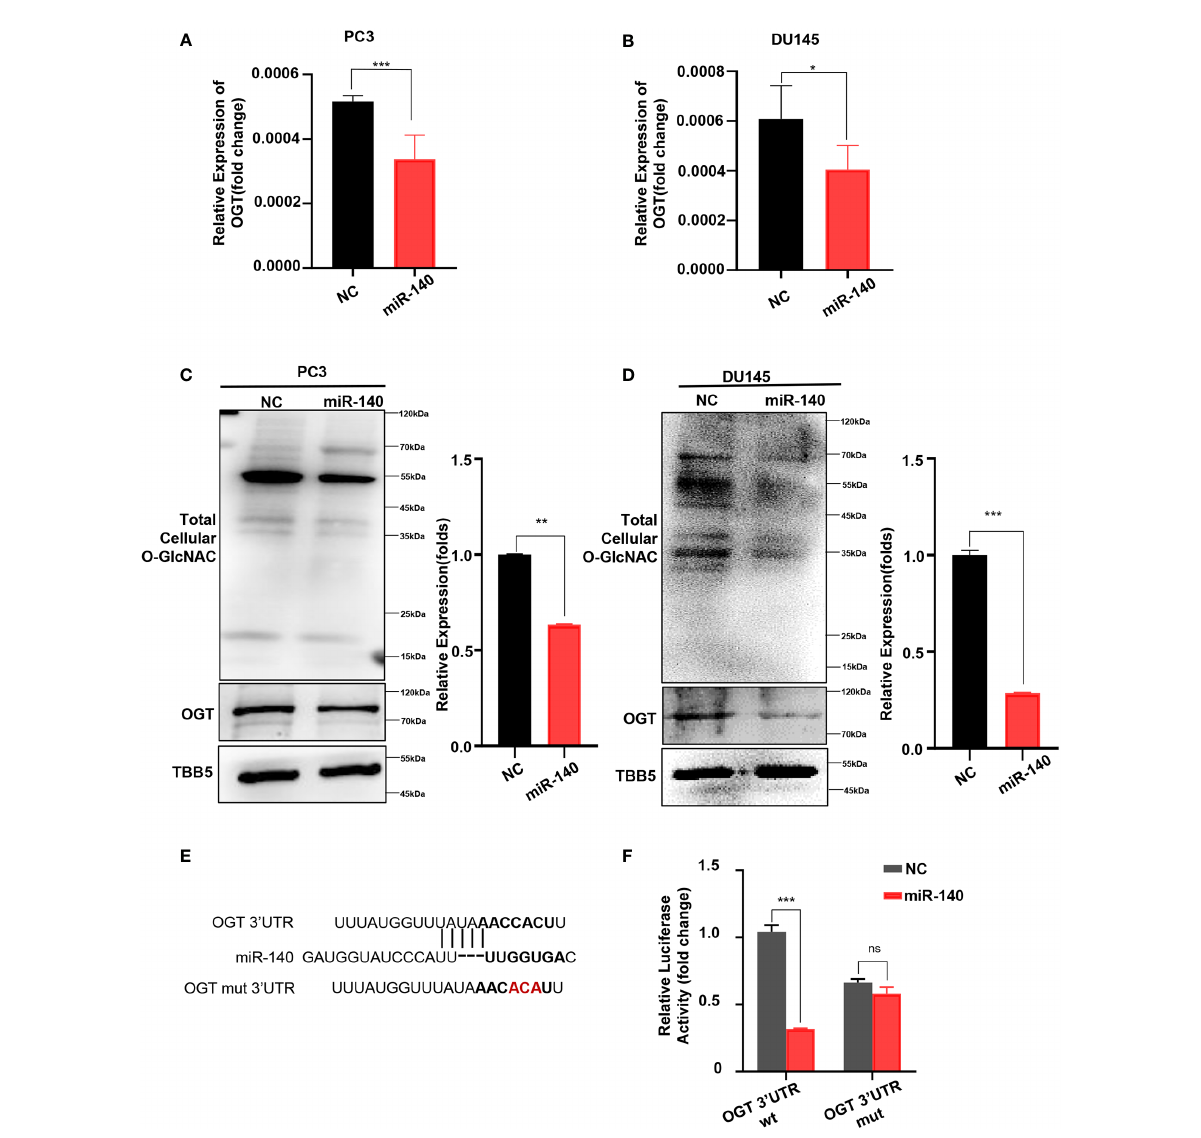
FIGURE 5 miR-140 targets and represses OGT expression. (A, B) Overexpression of miR-140 represses the OGT mRNA levels in PC3 and DU145 cells.